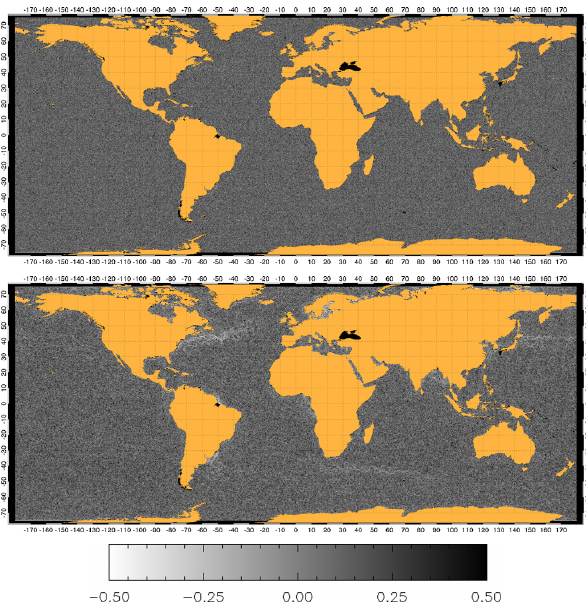
Fig. 10. Top: Singularity exponents associated with SSS after noise of unity amplitude and β = 1. Bottom: Singularity exponents de- rived from the fused SSS map.